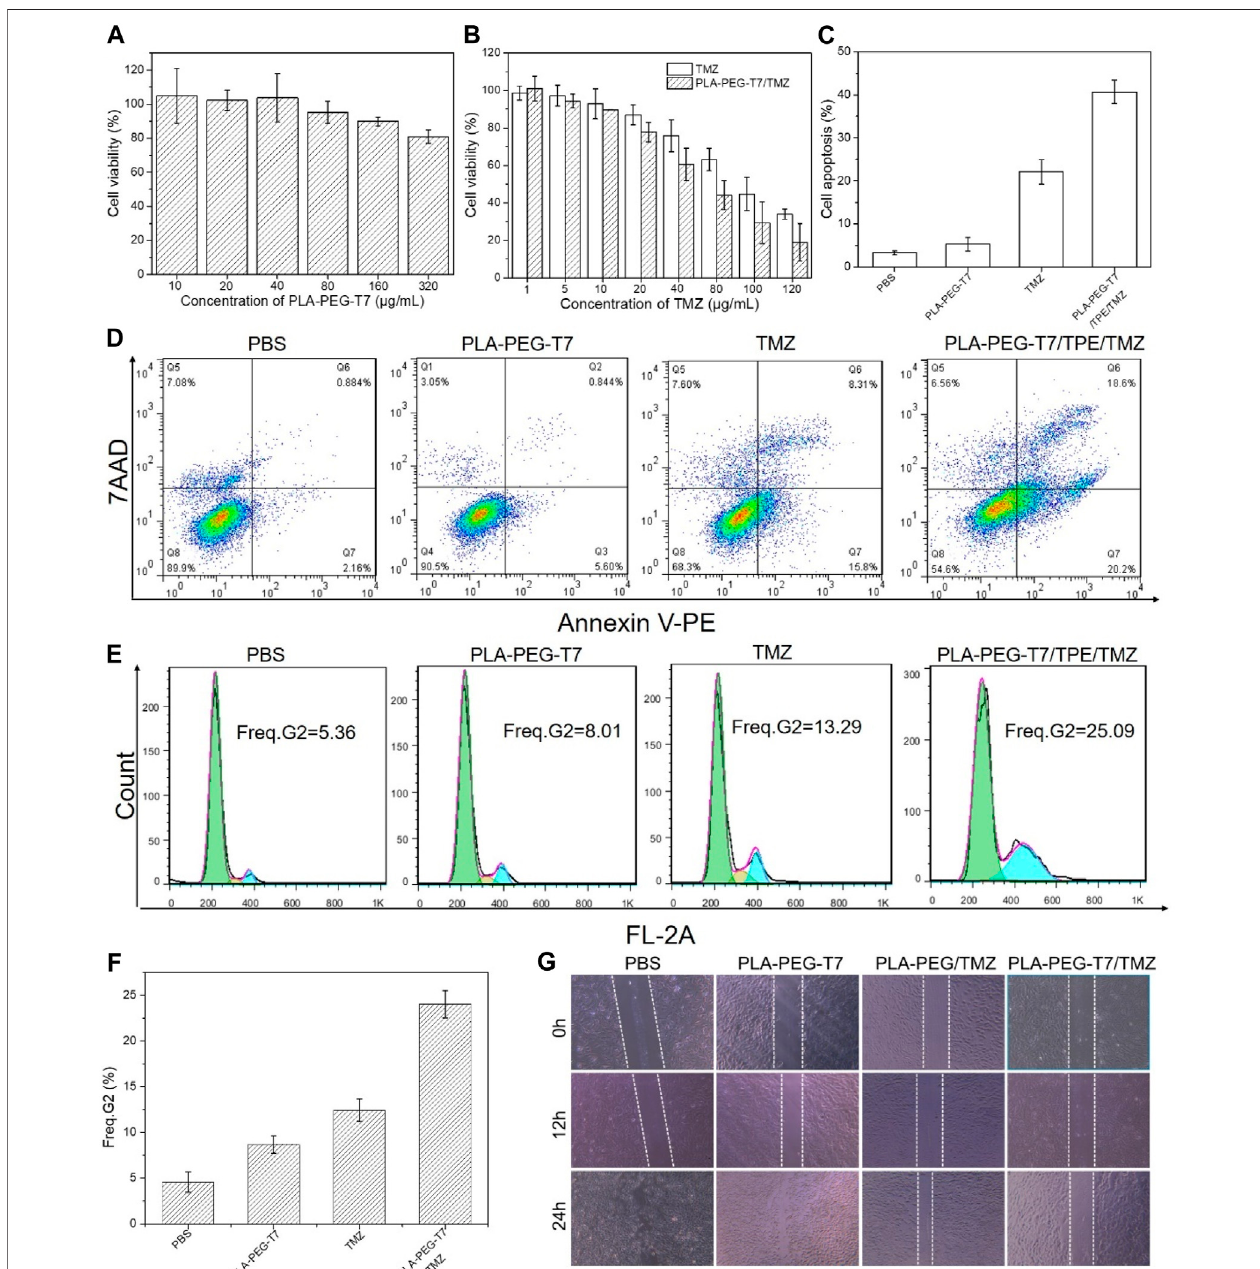
FIGURE 3 | (A) In vitro cytotoxicity of PLA-PEG-T7 with different concentrations on LN229 cells over an evaluation period of 24 h. (B) Cell viability of LN229 cells pretreated by TMZ and PLA-PEG-T7/TMZ with different concentrations. (C) Result histogram of apoptotic LN229 cells. (D) Apoptosis analysis by fl ow cytometry after LN229 cells incubated with various formulations using Annexin-V PE and 7-ADD dual-staining method. (E) Flow cytometry analysis of cell cycle in LN229 cells. (F) Freq. G2 of cell cycle in LN229 cells. (G) Scratch diagram of LN229 cells after treatment in different experimental groups.